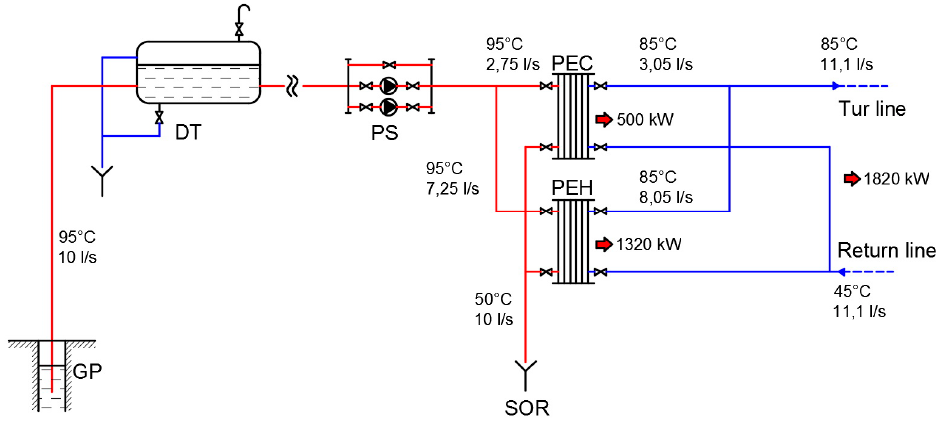
Figure 11. The basic design of the geothermal power station, adapted from [30] with the permisison from © General Association of Engineers in Romania, 2016; where: DT—degassing tank; PS—Pumping Station; GP—Geothermal; PEC—Plate exchanger for hot water consumption; PEH—Plate exchanger for hot water heating; SOR—Spill into Olt River.